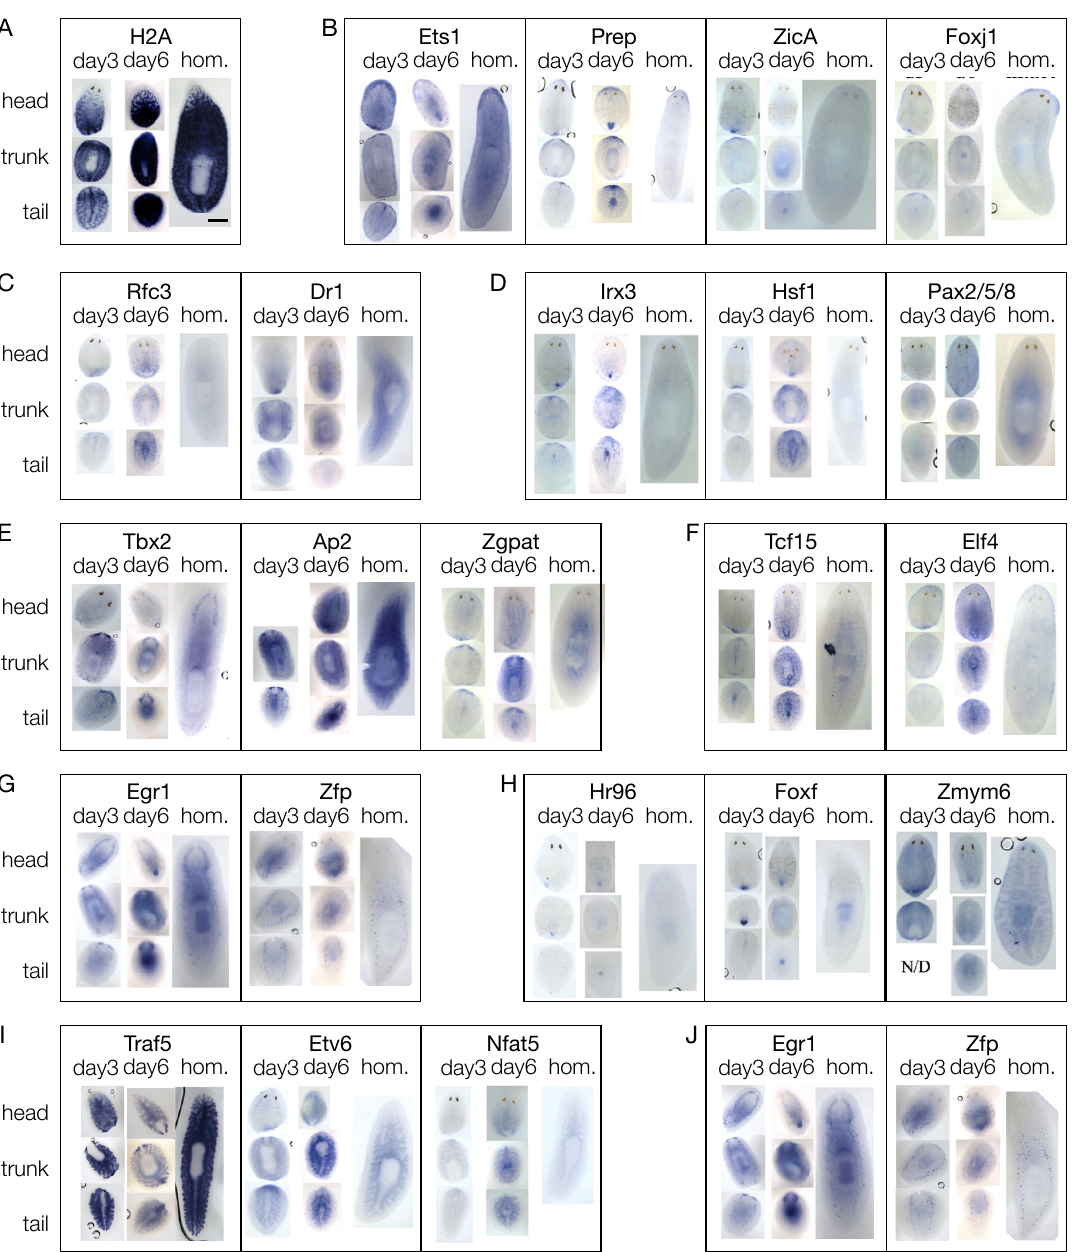
Figure 5. Expression of the shortlisted putative transcription factors in fragments at either day 3 or 6 of regeneration and in homeostatic animals, as for WISH. ( A ) SC-like patter of H2A. ( B ) Ets-1 , Prep , ZicA , and FoxJ1 were expressed in the region anterior to the photoreceptors. ( C ) Rfc3 and Dr1 were expressed along the midline. ( D ) Irx3 , Hsf1 , and Pax2/5/8 were expressed only in regenerating fragments, either in the blastema or in other districts, but not in homeostatic animals. ( E ) Tbx2, Ap2 , and Zgpat were expressed in the CNS. ( F ) Tcf15 and Elf4 were expressed in the mouth. ( G ) Egr1 and Zfp were expressed in the pharynx. ( H ) Hr96 , FoxF , and Zmym6 were expressed in both mouth and pharynx. ( I ) Traf5 , Etv6 , and Nfat5 were expressed in the intestine. ( J ) Egr1 and Zfp were expressed in the testes. Scale bar: 1 mm.